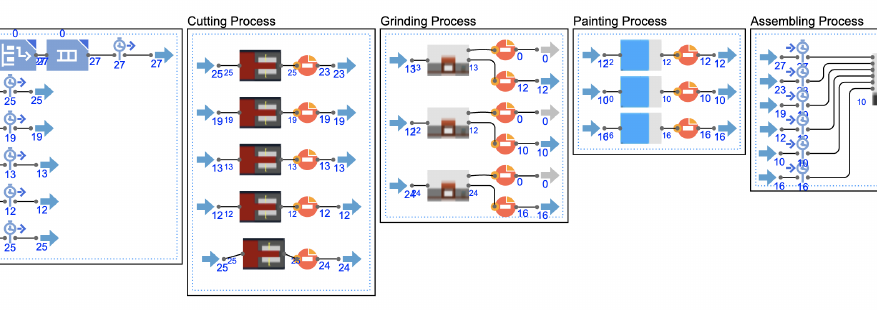
Figure 8. Time measuring points, Software: [10].